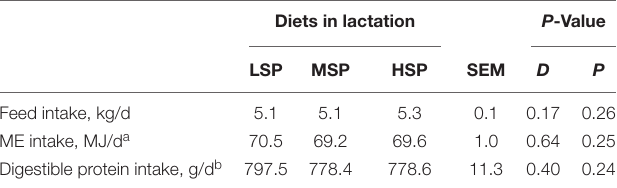
TABLE 2 | Feed, metabolizable energy (ME), and digestible protein intake between Days 2 and 21 post-farrowing in sows fed with different slow protein levels (LSmeans ± SEM).